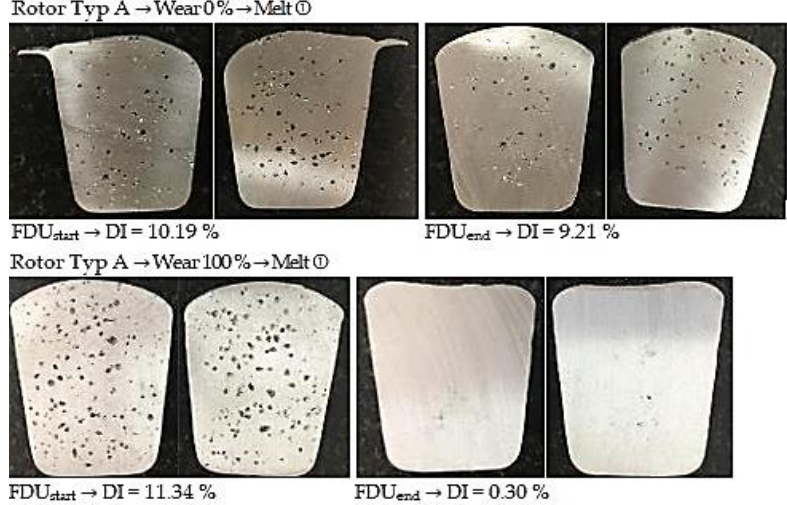
Figure 6. Comparison of degassing at 0% and 100% wear for Type A rotor.